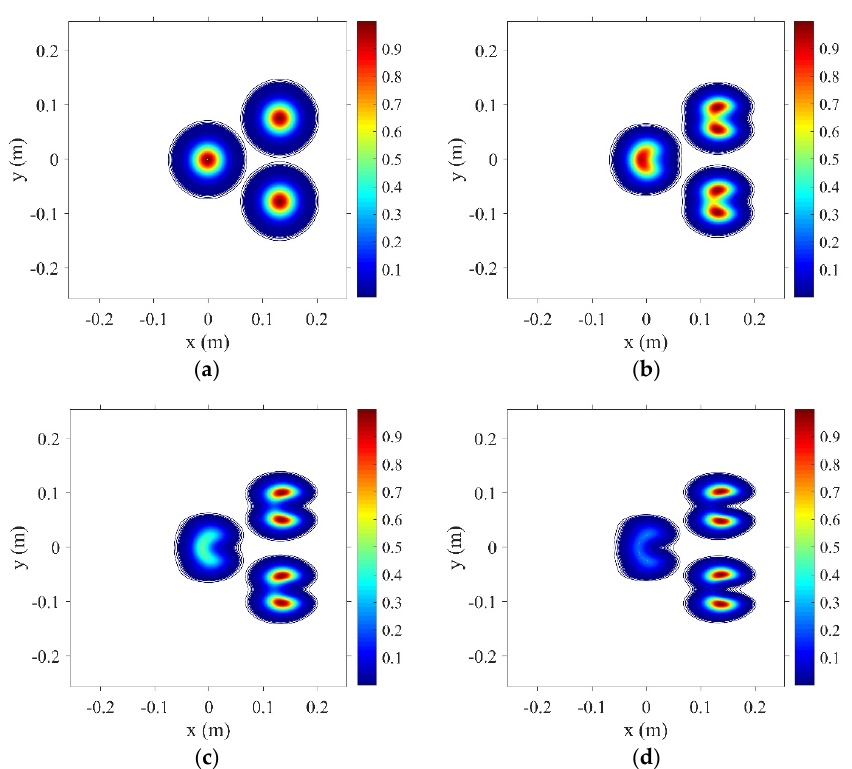
Figure 4. Thermal blooming of 3 − incoherent beams arranged as an inverted triangle, where ( a ) Initial arrangement; ( b ) N c = 0.5; ( c ) N c = 1.0 and ( d ) N c = 1.5.